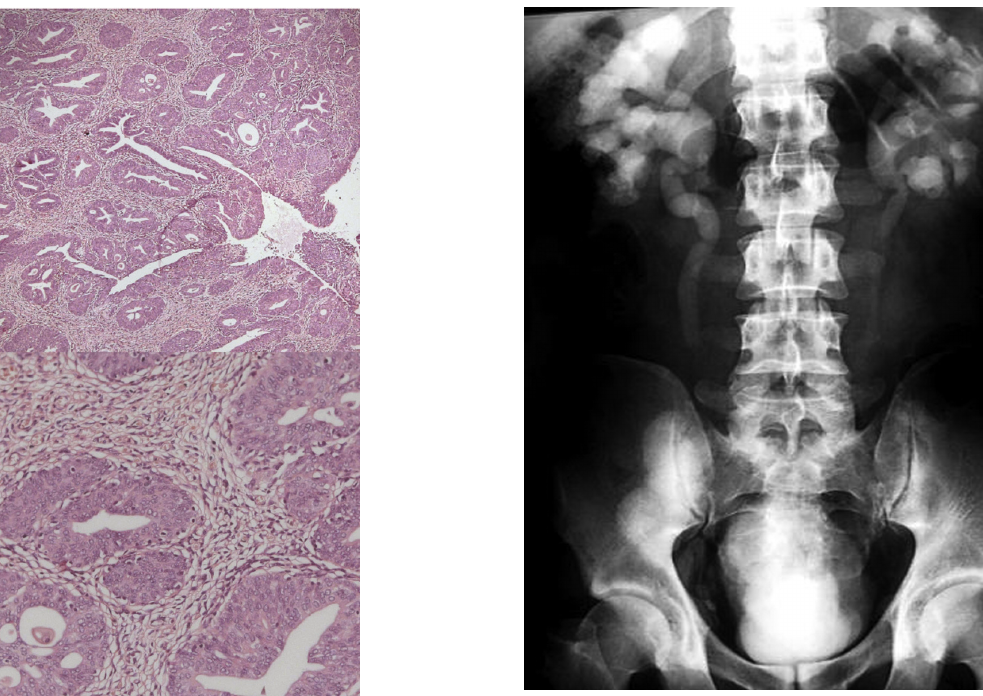
Figure 4 - Intravenous urography, at the 6-month follow-up, showing normal contrast excretion and marked reduction of